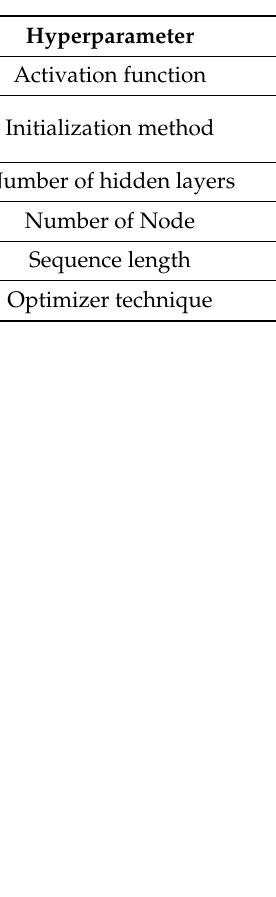
Figure 6. Comparisons of The root mean square error (RMSE), mean absolute error (MAE), and coefficient of determination (R 2 ) based on best hyperparameter. The 1) , 2) , 3) , and 4) denote activation function, the number of hidden layers, number of nodes, and sequence length, respectively. Table 3. Reliable hyperparameters of deep neural network (DNN), long-short term memory (LSTM), and gated recurrent unit (GRU), LSTM-DNN, and GRU-DNN.